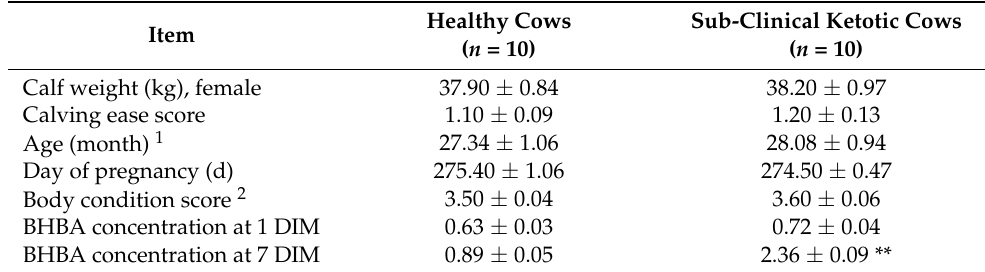
Table 1. Calf weight, calving ease score, body condition score, age, actual days of pregnancy, and beta-hydroxybutyric acid level between the healthy and sub-clinical ketotic dairy cows. Healthy Cows Sub-Clinical Ketotic Cows Item ( n = 10) ( n =